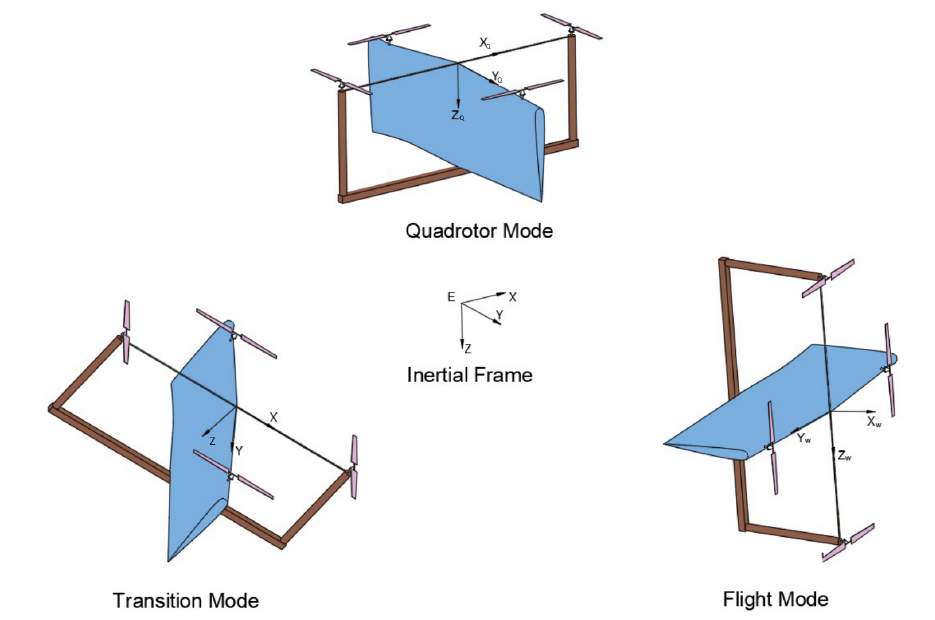
Figure 1. Quadrotor tail-sitter